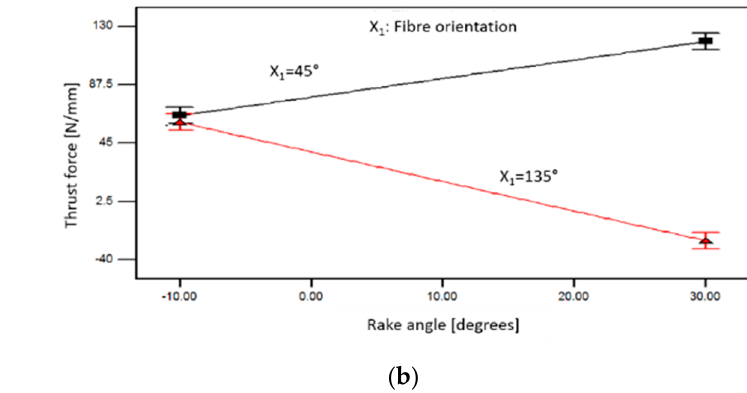
Figure 25. The combined effect of orientation of fibres and tool rake angle on the thrust force when machining at DOC: 100 µ m ( a ) 3D view, and ( b ) fibre orientations of 45 ◦ and 135 ◦ .